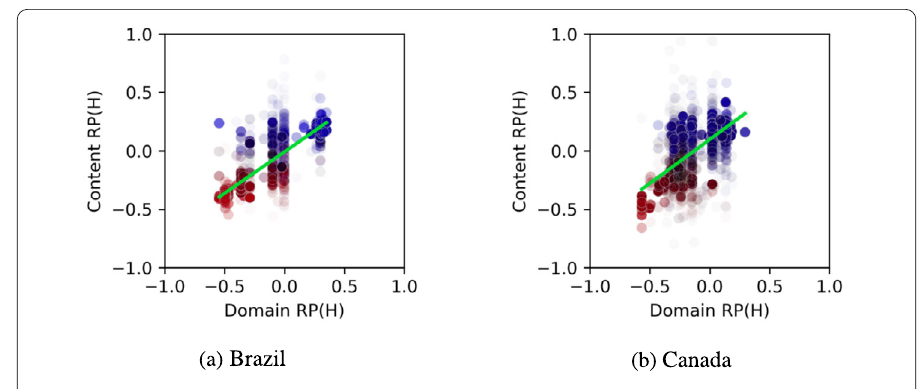
Figure 12 Correlation between retweeted Domain RP ( H ) and Content RP ( H )